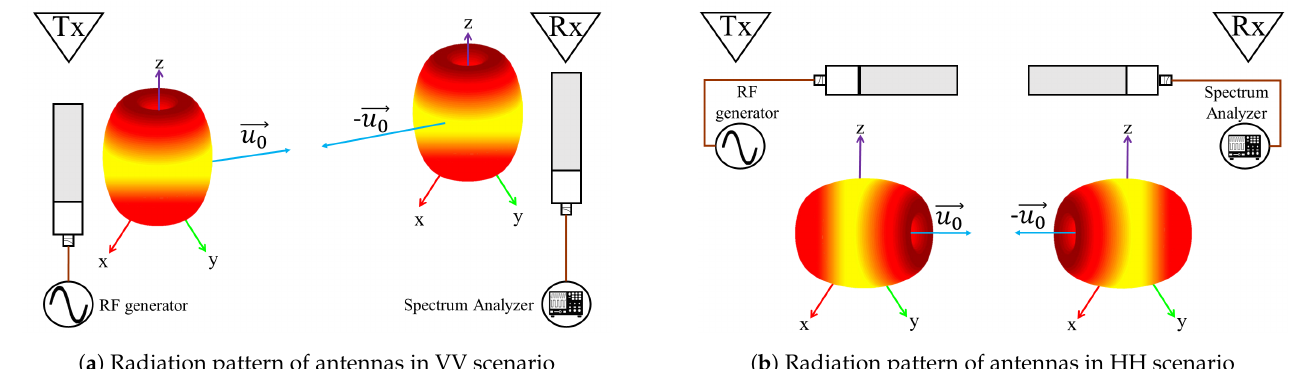
Figure 4. Radiation pattern and polarization of antennas configuration in both scenarios.